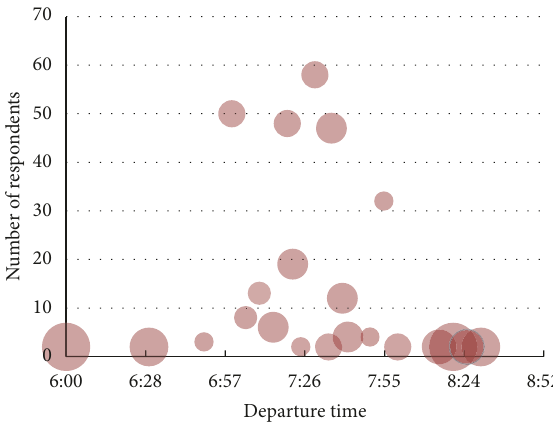
Figure 5: Cumulative distribution of departure time decision.